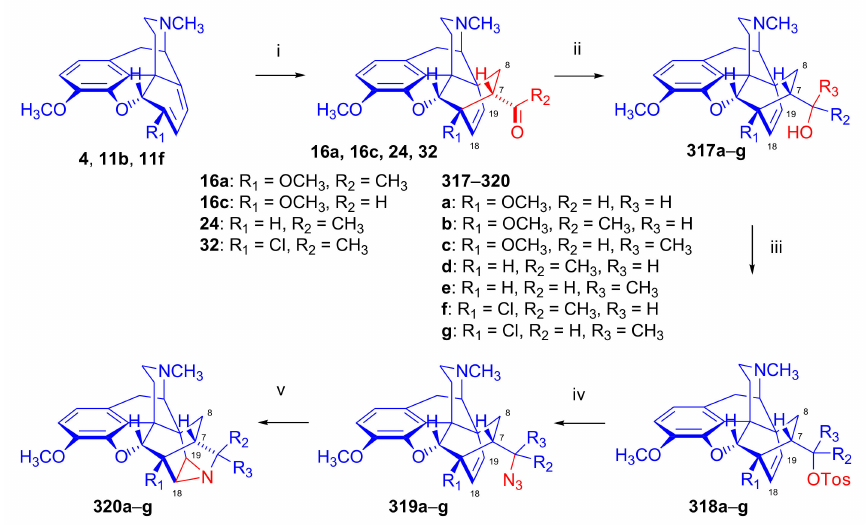
Figure 83. Synthesis of morphinans with a 4-azatetracyclo-[4.4.0.0 3,8 .0 2,4 ]-decane ring system. Reagents and conditions : (i): acrolein or methyl vinyl ketone, toluene, reflux 24 h; (ii): 4.5 equiv. sodium borohydride, methanol, 0 ◦ C, 30 min; (iii): 1.5 equiv. TosCl, pyridine, room temperature, one day to 6 days; and (iv,v): 5 equiv. sodium azide, H 2 O, 100 ◦ C, 24